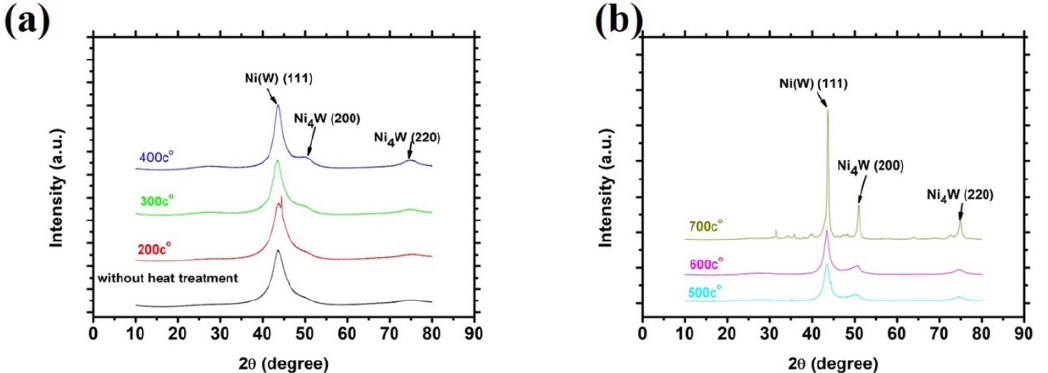
Figure 3. XRD patterns of the Ni-W/B composite coatings fabricated at 75 °C, 5 g/L boron concentration, 0.1 A/cm 2 current density and 8.9 pH and various heat treatment temperatures. ( a ) without heat treatment and with heat treatment temperature of 200-400 °C; ( b ) with heat treatment temperature of 500–700 °C.